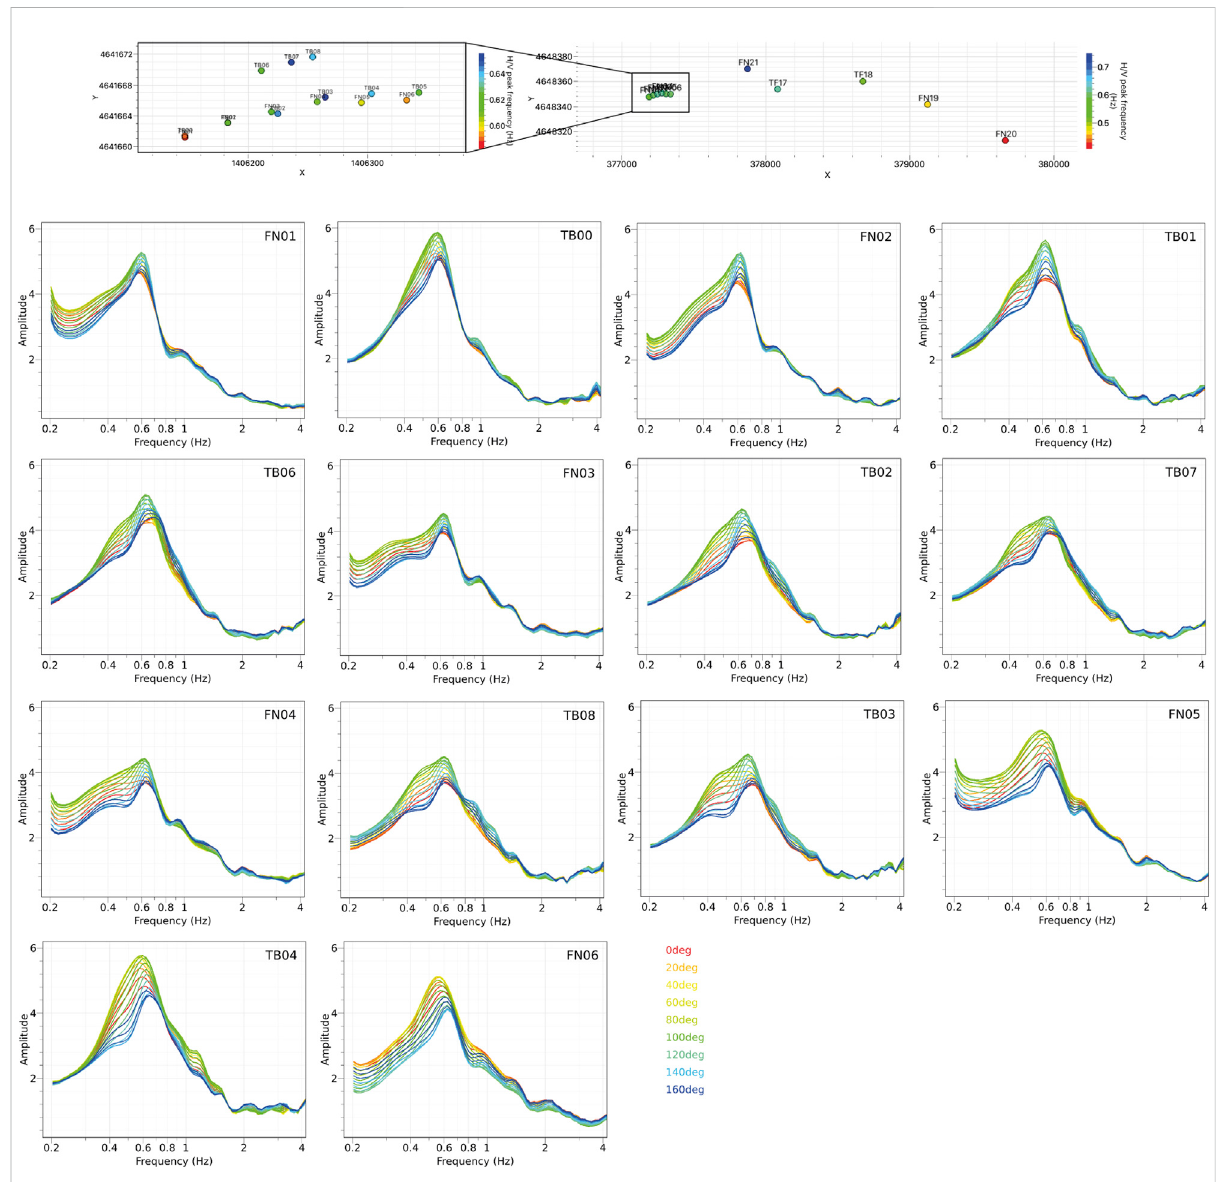
FIGURE 11 Directional HVNSR of Section